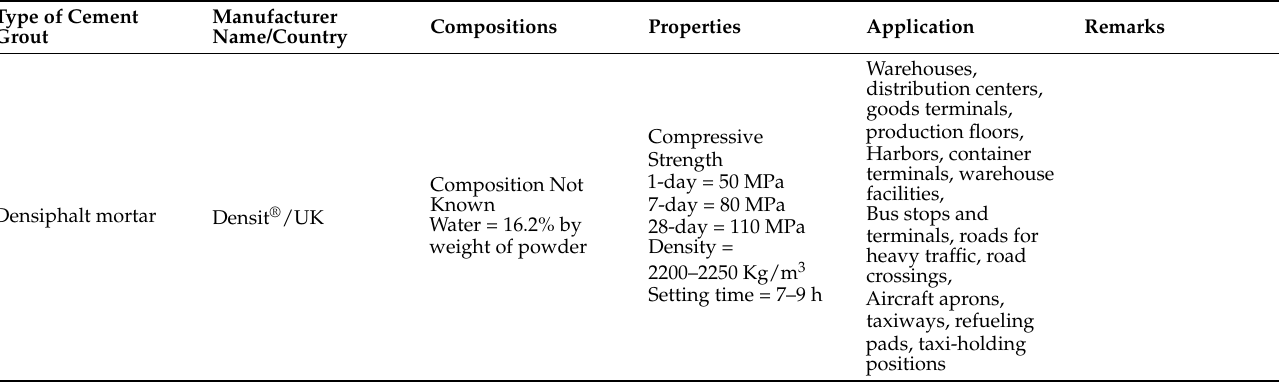
Table 8. Technical data of commercially available cement